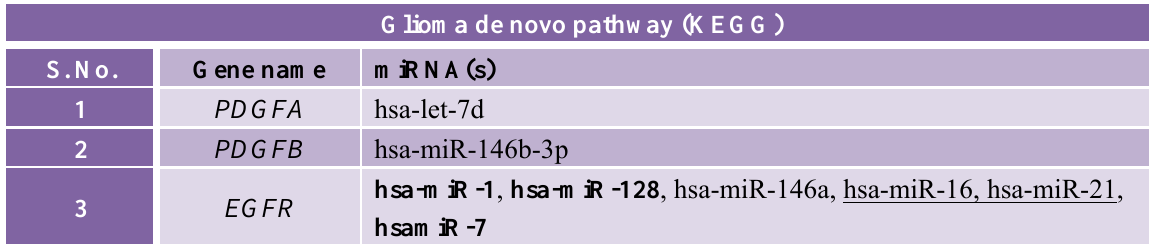
Table 2. Experimentally validated targets of miRNAs are components of pathways known to play key role in GBM biology. MicroRNAs shown underlined are over expressed and shown in bold are under expressed miRNAs in